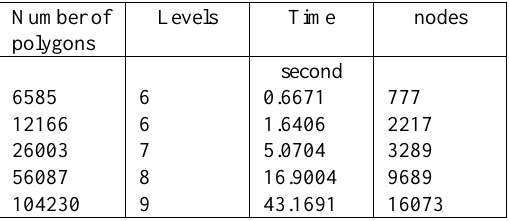
Table 1. Costs for the improved quadtree index construction To test the query efficiency, 5 times experiments are made. 100 query points and 100 rectangles are produced in the test area randomly every time. The result is shown in table 2.